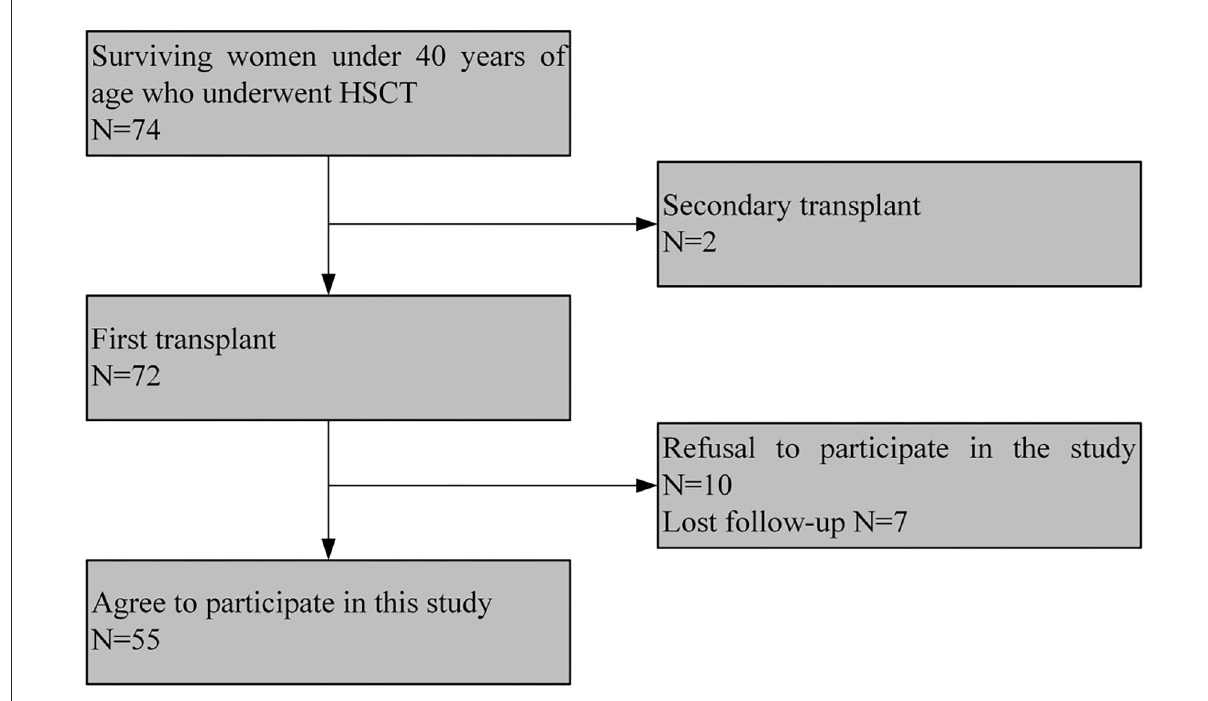
FIGURE1 Consort diagram of